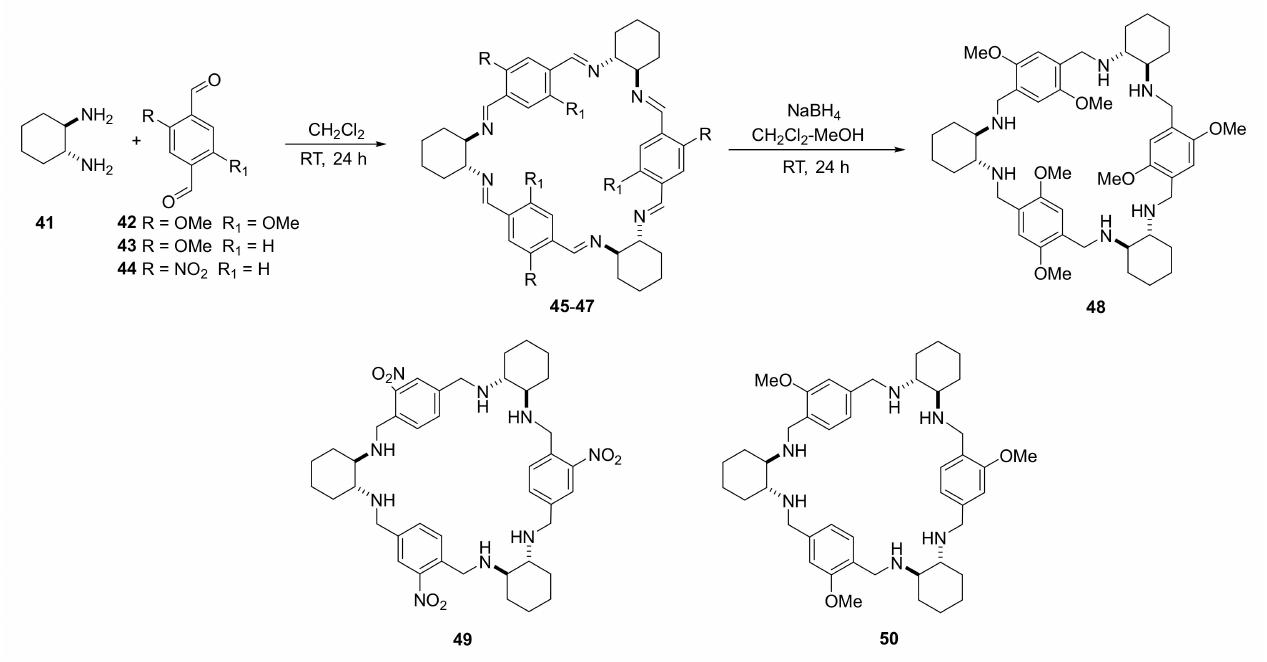
Figure 7. Synthesis of triangular heksaimines 46 – 47 and related heksaimines 48 – 50 displaying gelation